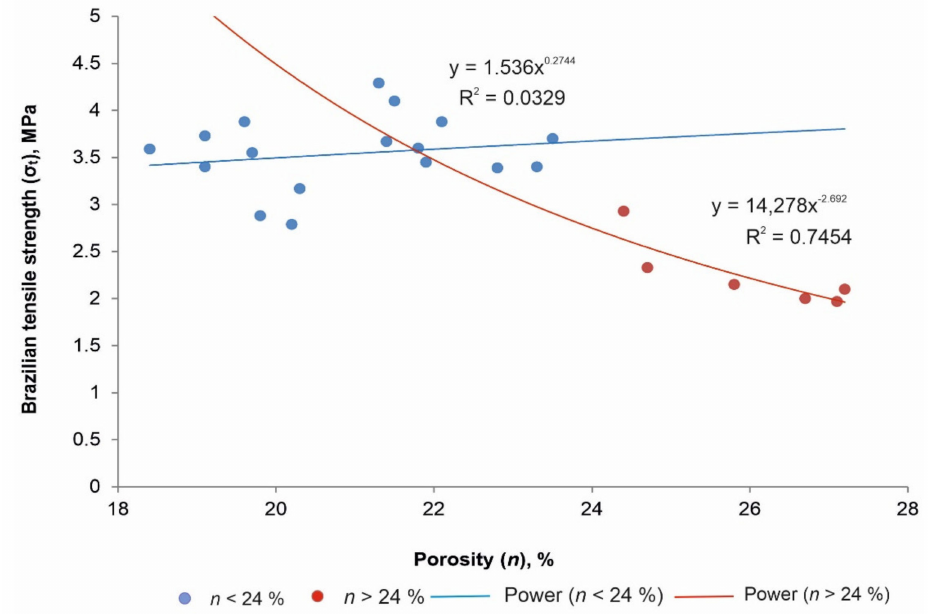
Figure 8. Relations between indirect (Brazilian) tensile strength ( σ t ) and two different level of porosity ( n < 24 % and n > 24 %) for the zeolite-bearing